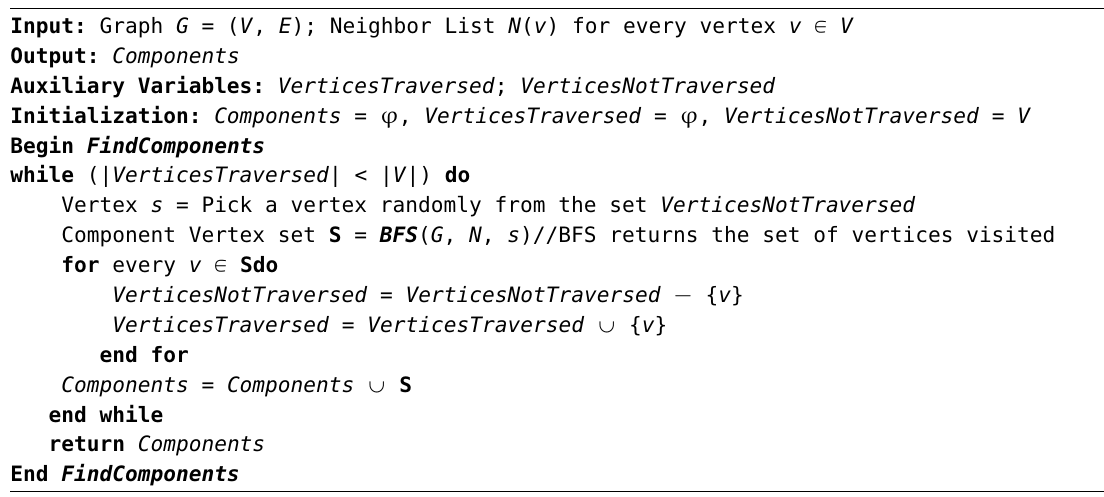
Algorithm 4 Pseudo Code to Determine All the Connected Components of a Graph